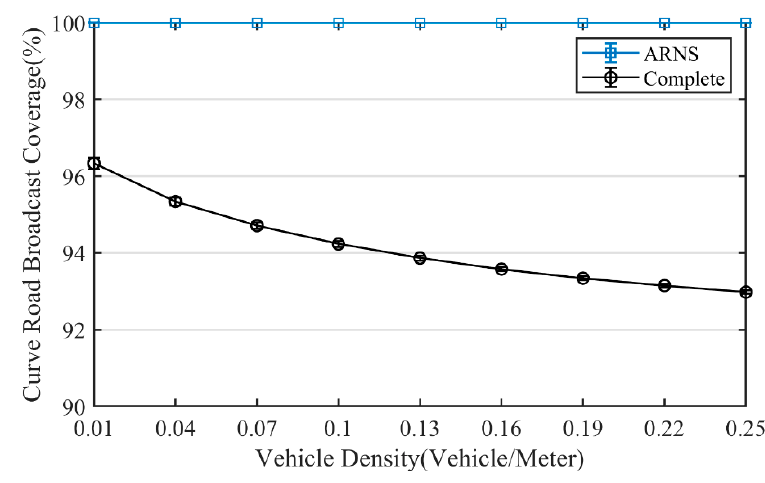
Figure 7. Broadcast coverage.